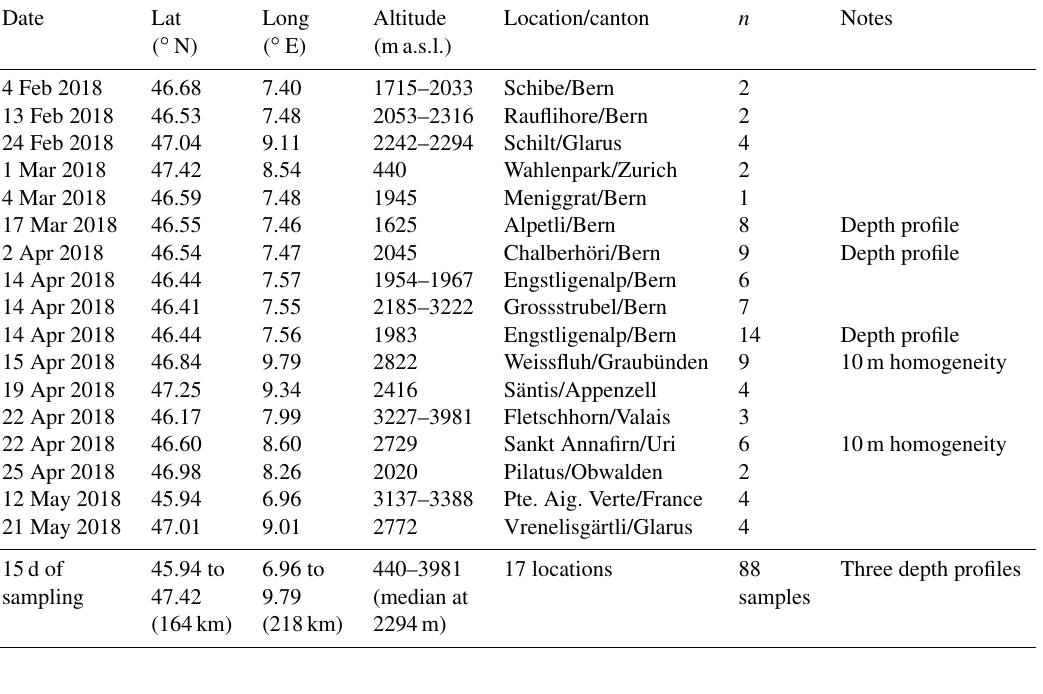
Table 1. List of dates, sites (latitude and longitude), altitude, location including the Swiss canton and number ( n ) of samples collected, during this Swiss alpine snow sample study. Additional details with recorded parameters for each sample are available in the Supplement. See Fig. S5 for selected images of the different sites.